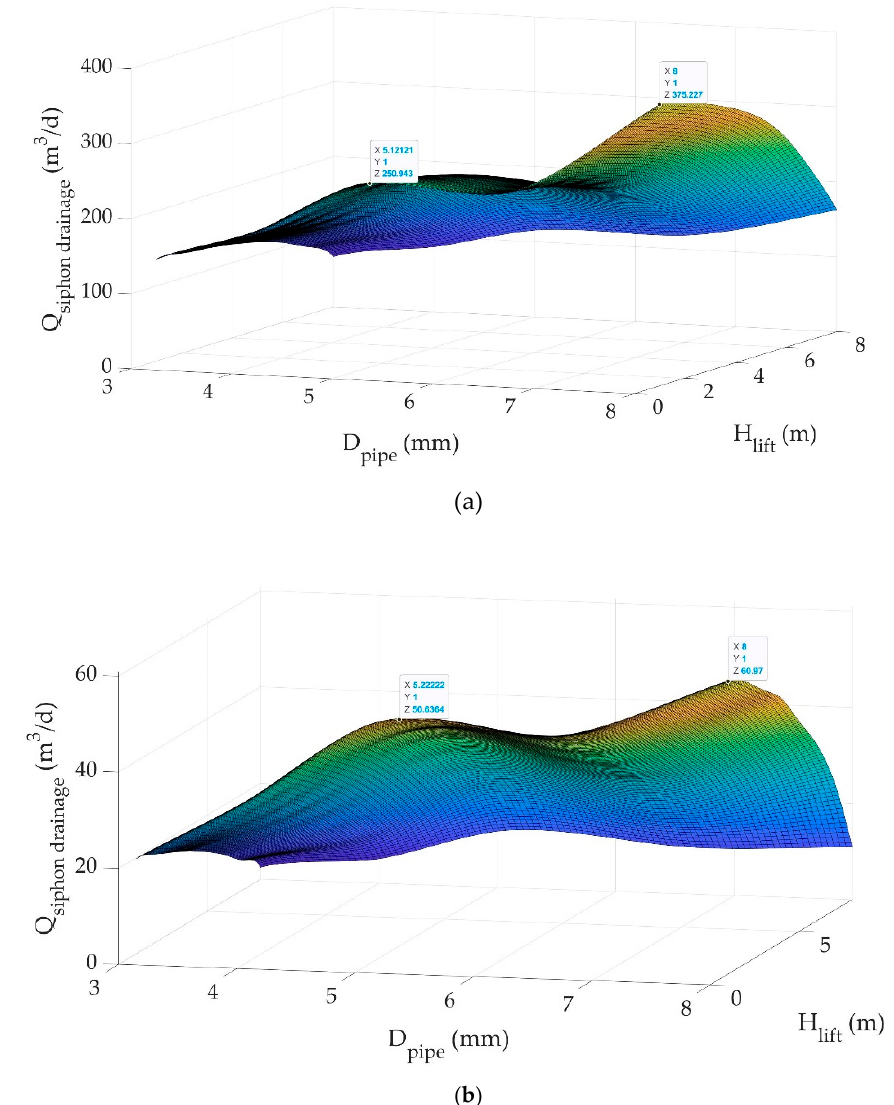
Figure 13. Drainage capacity under engineered piping conditions in 10 cm diameter boreholes: ( a ) siphon length 30 m; ( b ) siphon length 200 m.